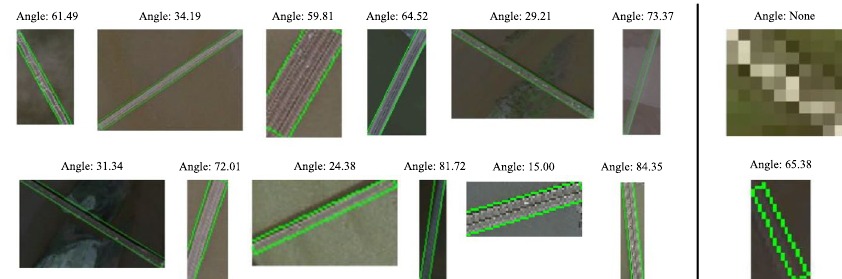
Fig. 9 Examples of bounding box conversion